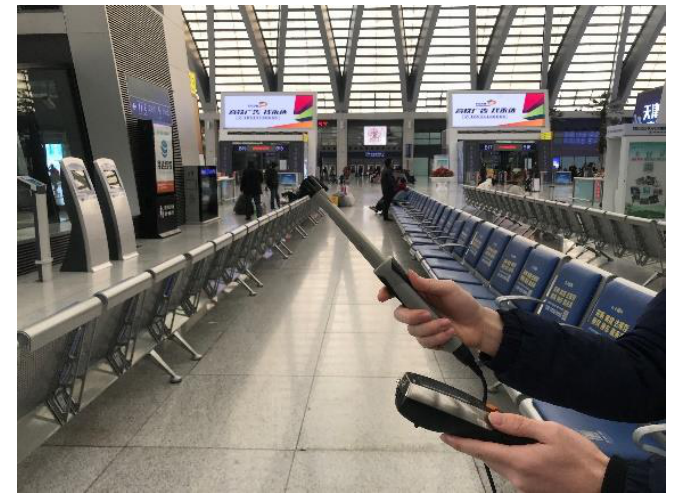
Figure 8. Tests of waiting lounge for B3.